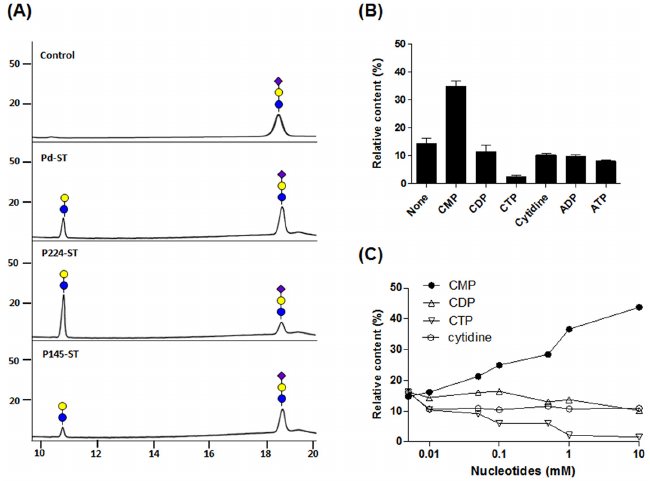
Fig 4. Sialidase activity analysis of bacterial α (2,6)-STs. (A) Removal of SA from AA-labeled 6 ’ - sialyllactoses by Pd-, P224-, and P145-STs was analyzed using HPLC. Symbols for galactose and Neu5Ac are the same as in Fig 2, while glucose is represented by a blue circle. (B) The effects of nucleotides (CMP, CDP, CTP, cytidine, ADP, and ATP) on the α (2,6)-sialidase activity of P145-ST were examined. Reaction mixtures containing 1 mM of each nucleotide were incubated for 2 h. (C) Changes of P145-ST sialidase activities were also analyzed with addition of various concentrations (0.01, 0.05, 0.1, 0.5, 1, and 10 mM) of CMP (filled circle), CDP (triangle), CTP (reverse triangle), and cytidine (filled circle). The reaction mixtures were incubated for 2 h at 37°C. Relative contents (%) of lactose generated by sialidase activity were obtained by the calculation of integrated peak areas (100 × [The areas of lactose peaks]/[Total areas of lactose and sialyllactose peaks]).